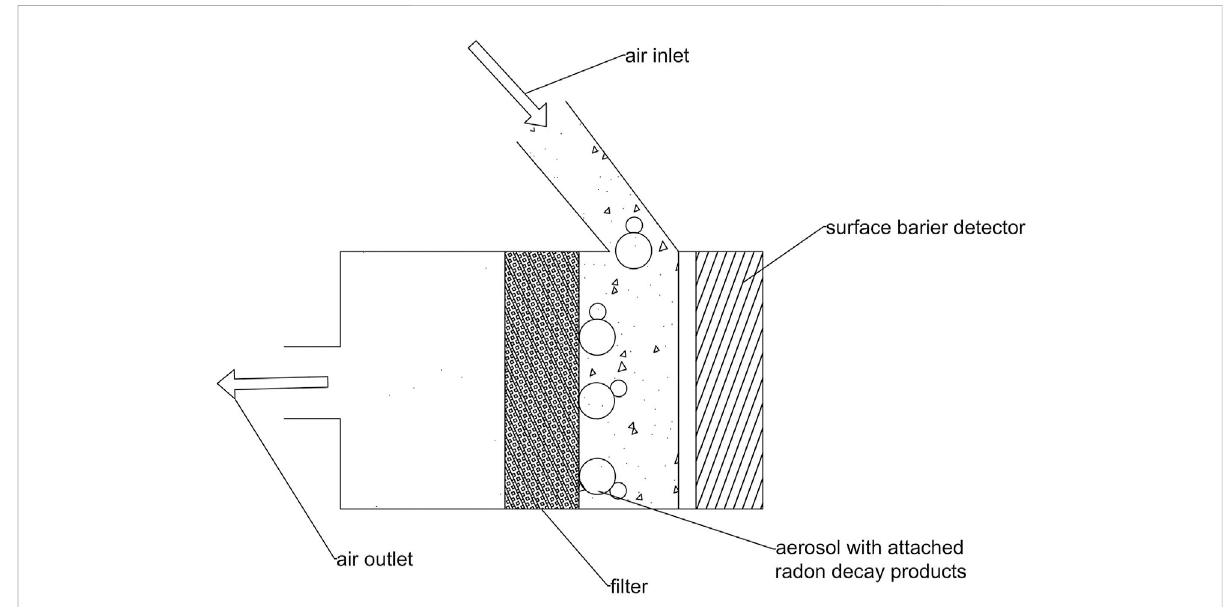
FIGURE 1 Scheme of the Rn monitor measurement head. Own study based on investment (Levin,